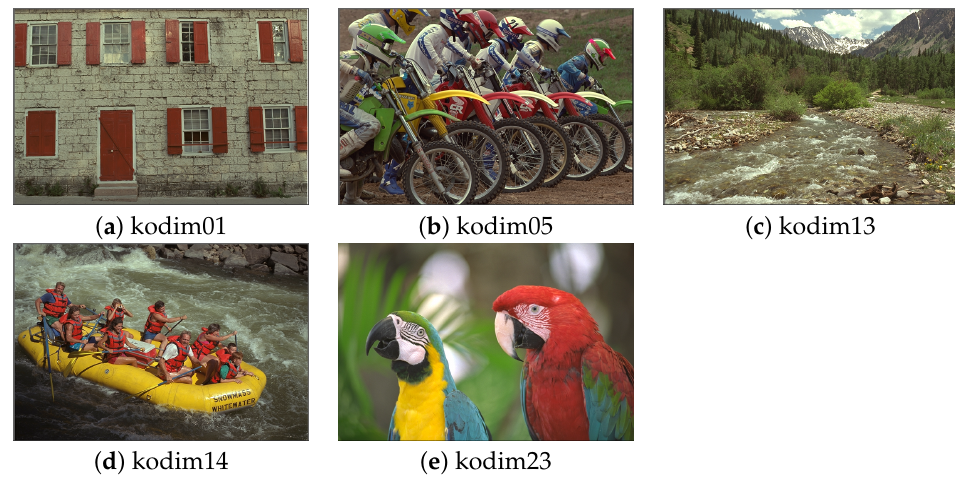
Figure 3. Selected Kodak test